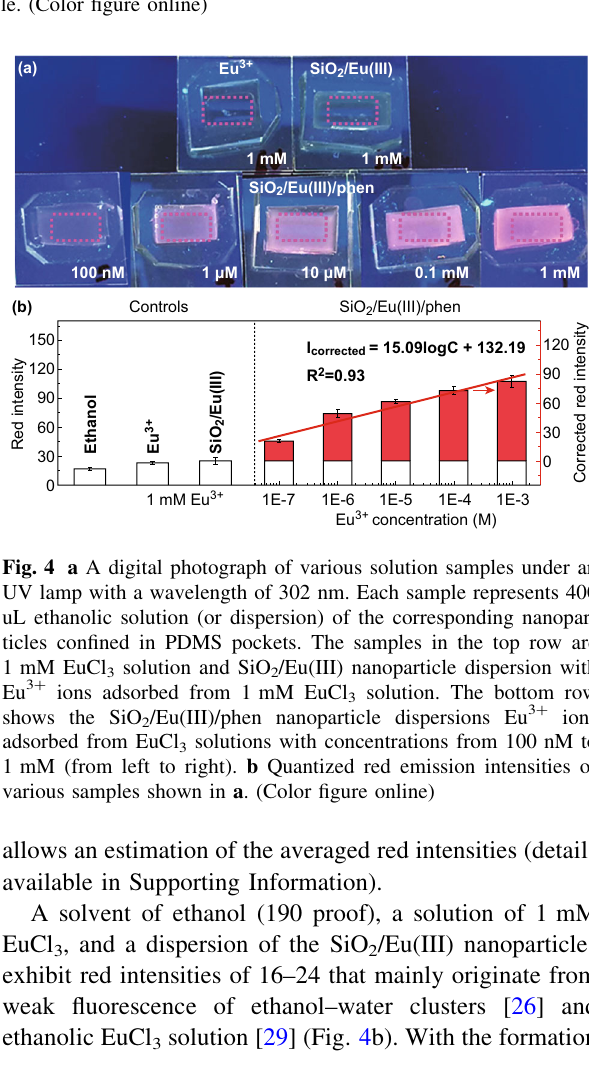
Fig. 3 EDX elemental mapping images of a overlaid Si, O, and Eu elements, b Si, c O, d Eu for SiO 2 /Eu(III)/phen nanoparticles. The scale bars represent 250 nm. The red circles in ( b – d ) highlight the same nanoparticle. (Color figure online)